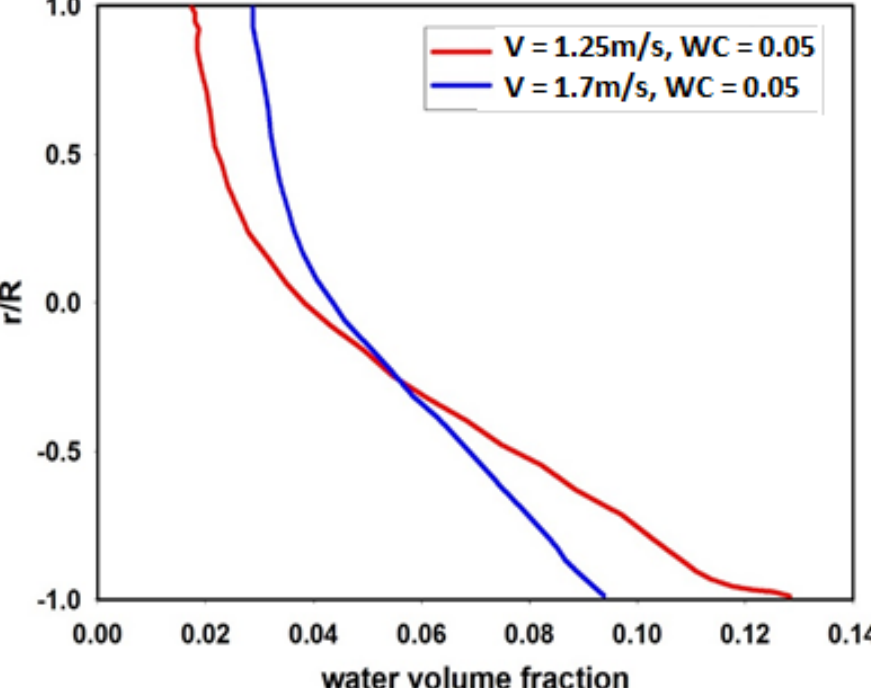
Figure 5. Vertical profile of in situ water volume fraction for test 1 (V = 1.25 m/s, water cut = 0.05) and test 2 (V = 1.7 m/s, water cut = 0.05).